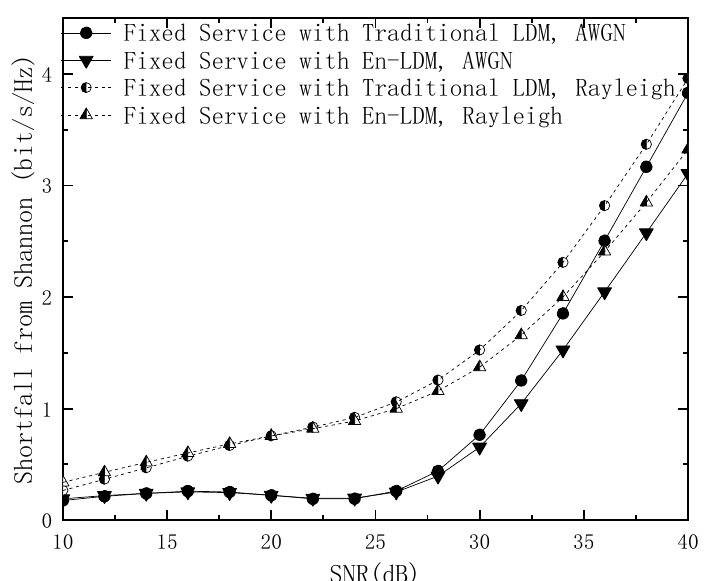
Figure 4. The shortfall from Shannon for the fixed service of the LDM and En-LDM systems under the AWGN and Rayleigh channels, where the parameters of the LDM and En-LDM systems were set to ∆ = 10 dB, B f / B t = 1/4, the CL constellation was set to QPSK, and the EL constellation was set to NU−64QAM.